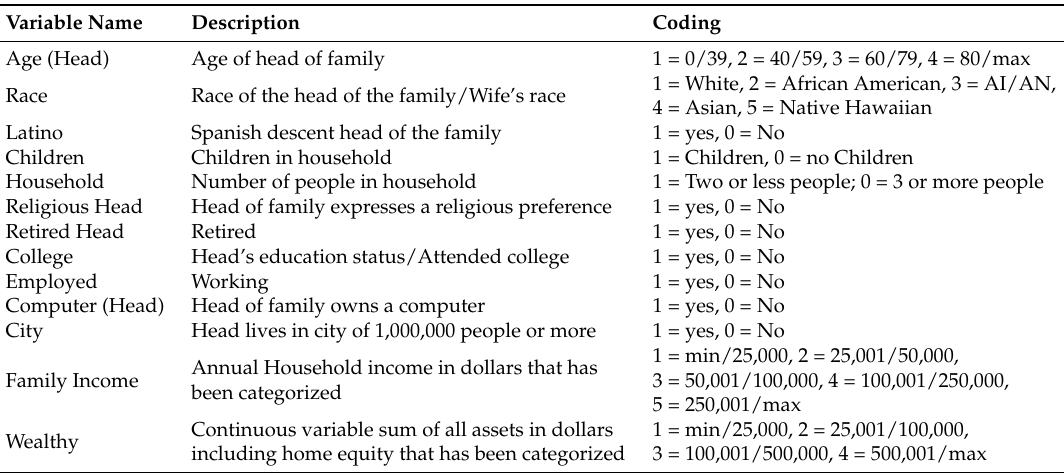
Table 2. Independent variable